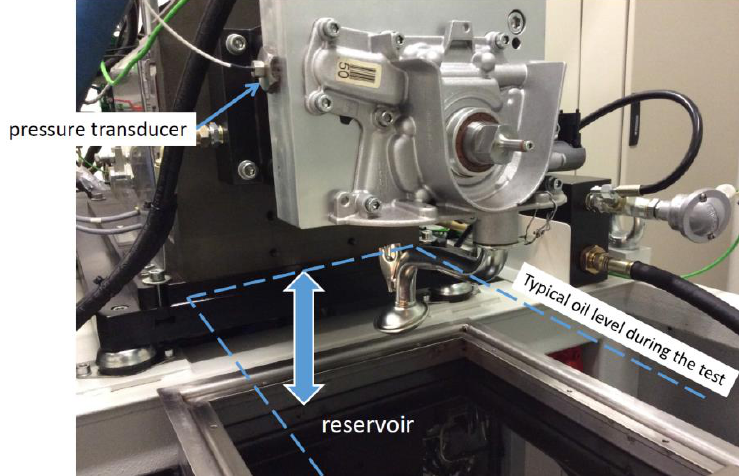
Figure 5. Photo of the pump mounted on the test rig with the indication of the oil level when the reservoir is positioned in the test mode.